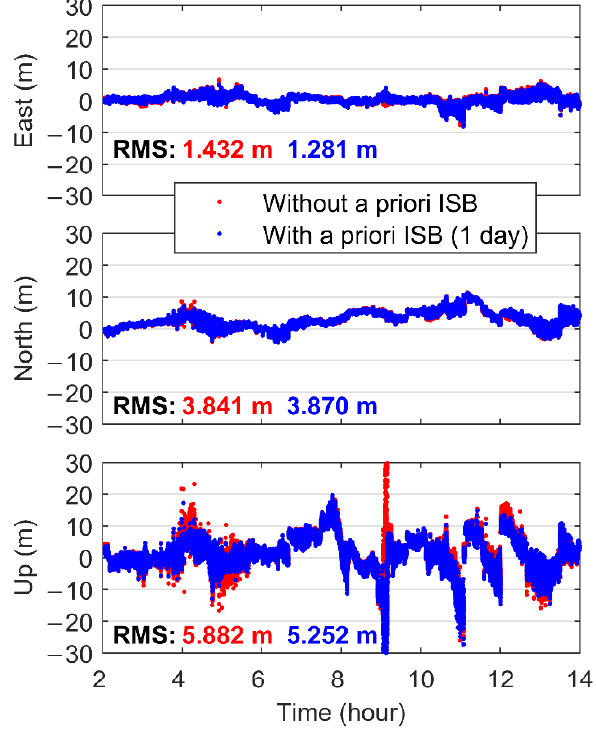
Figure 14. Epochwise positioning errors of GPS/GLONASS integrated SPP with and without a priori ISB constraints using the low-cost u-blox M8T receiver under a cutoff elevation of 30° on DOY 305 of 2021.